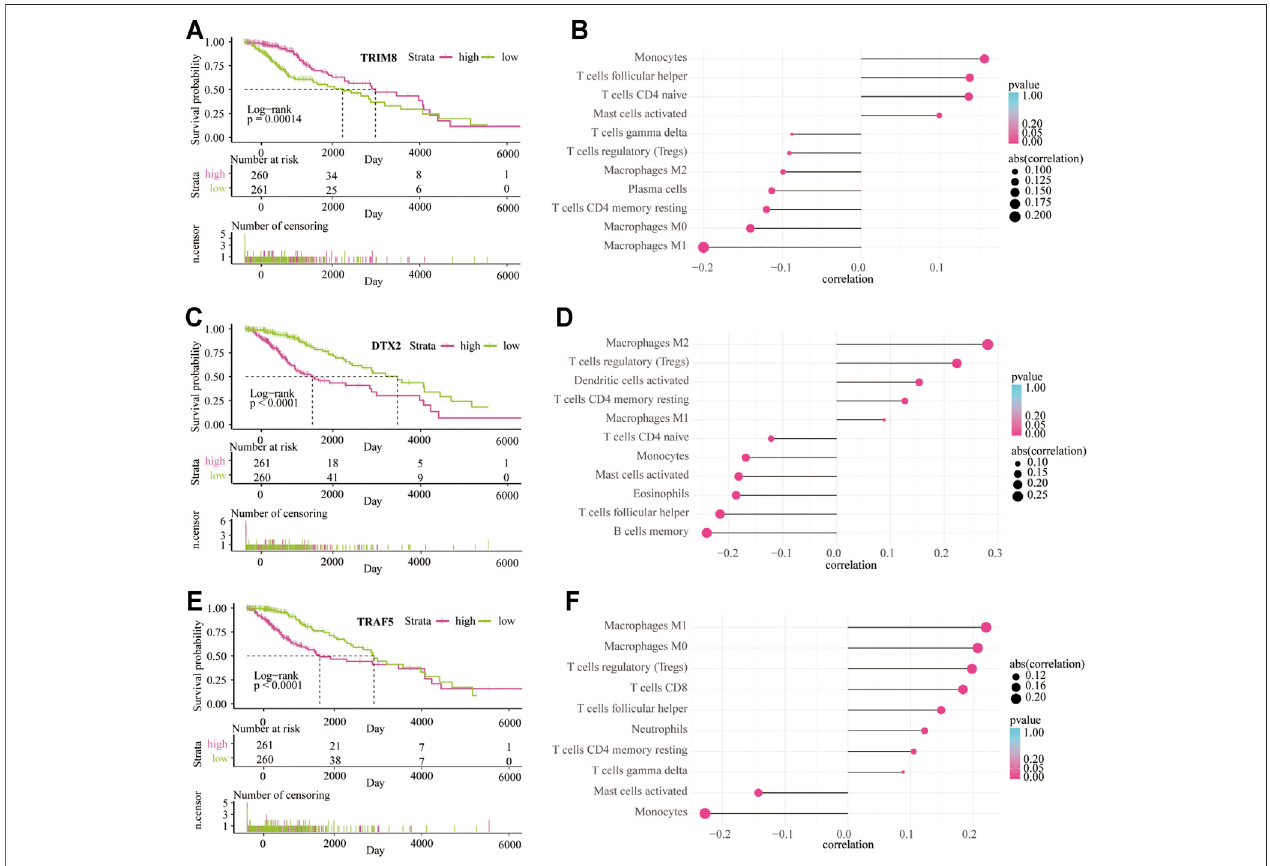
FIGURE9| Thesurvivalanalysisandimmunein fi ltratearebasedontheexpressionofthreemaincontributors.Kaplan – Meieroverallsurvivalcurvebetweenlow-risk andhigh-riskgroupsbasedontheexpressionofTRIM8 (A) ,DTX2 (C) ,andTRAF5 (E) .CIBERSORTalgorithmshowstherelationshipbetweentheimmunein fi ltratesand the expression of TRIM8 (B) , DTX2 (D) , and TRAF5 (F) .